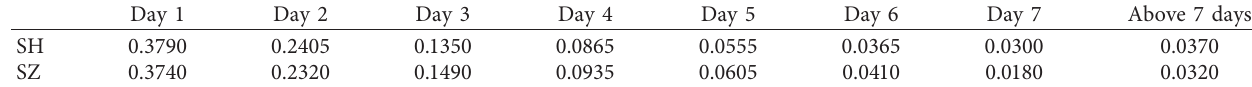
Table 4: Frequencies of the first extreme jump occurrence on following days.